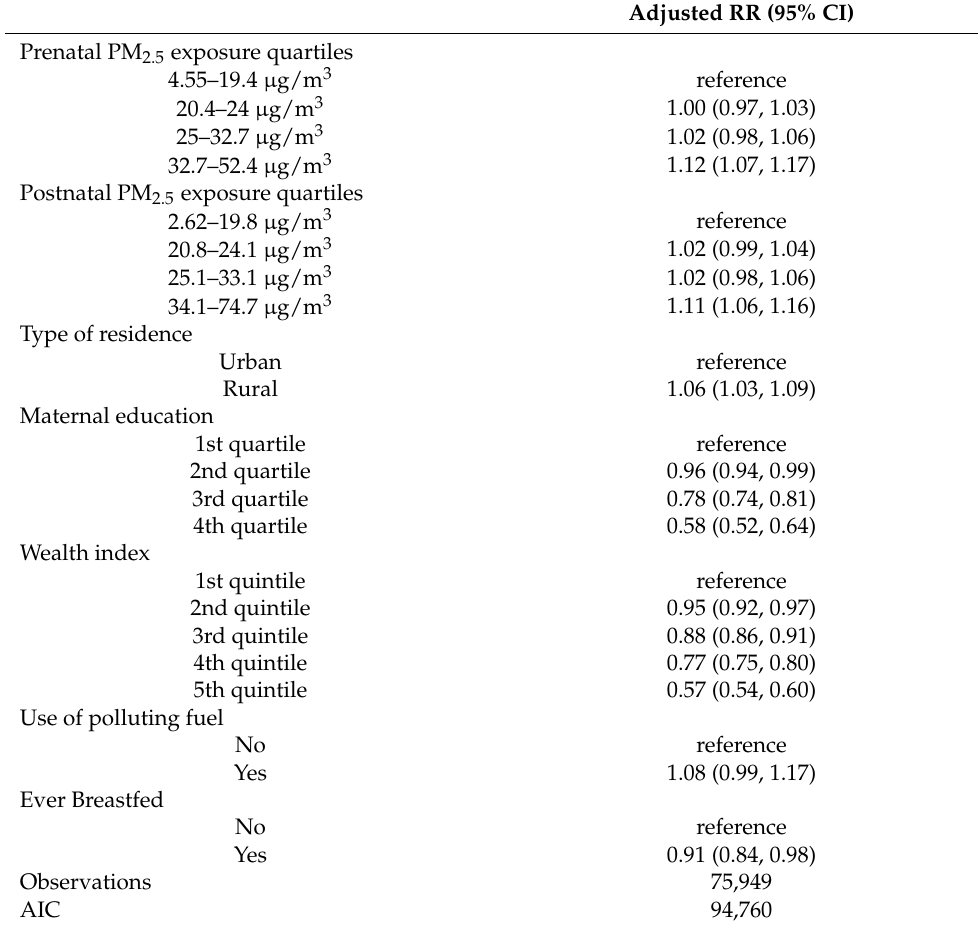
Table 5. Adjusted relative risks of quartiles of prenatal and postnatal PM 2.5 exposure for stunting among children under 5 years old in the East Africa